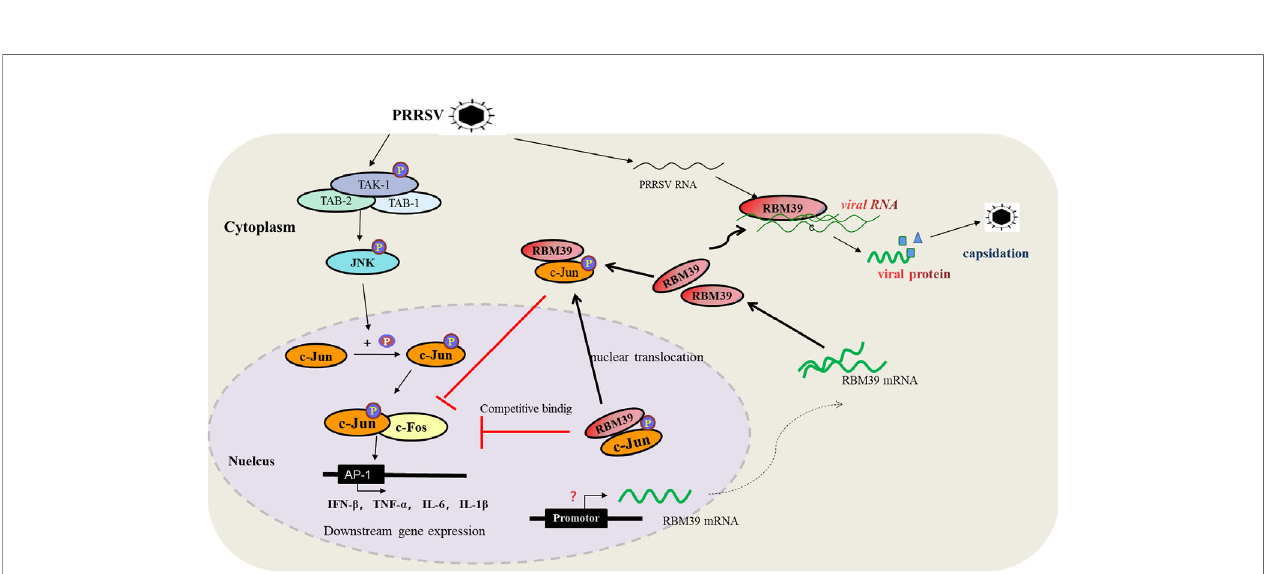
FIGURE 9 | The diagram of the mechanism of RBM39 promoting PRRSV proliferation. After PRRSV infection, the combination of RBM39 and c-Jun translocates to the outside of the nucleus together under certain effects, which hinders the phosphorylation of c-Jun by JNK and reduces the level of c-Jun phosphorylation. At the same time, RBM39 competes with c-Fos to bind c-Jun and robs c-Jun of AP-1 dimer, which reduces the number of AP-1 dimers, and then down-regulates the activity of AP-1 pathway and its downstream signals, and fi nally, promotes the proliferation of PRRSV. In addition, the combination of RBM39 and PRRSV RNA may promote PRRSV proliferation to some